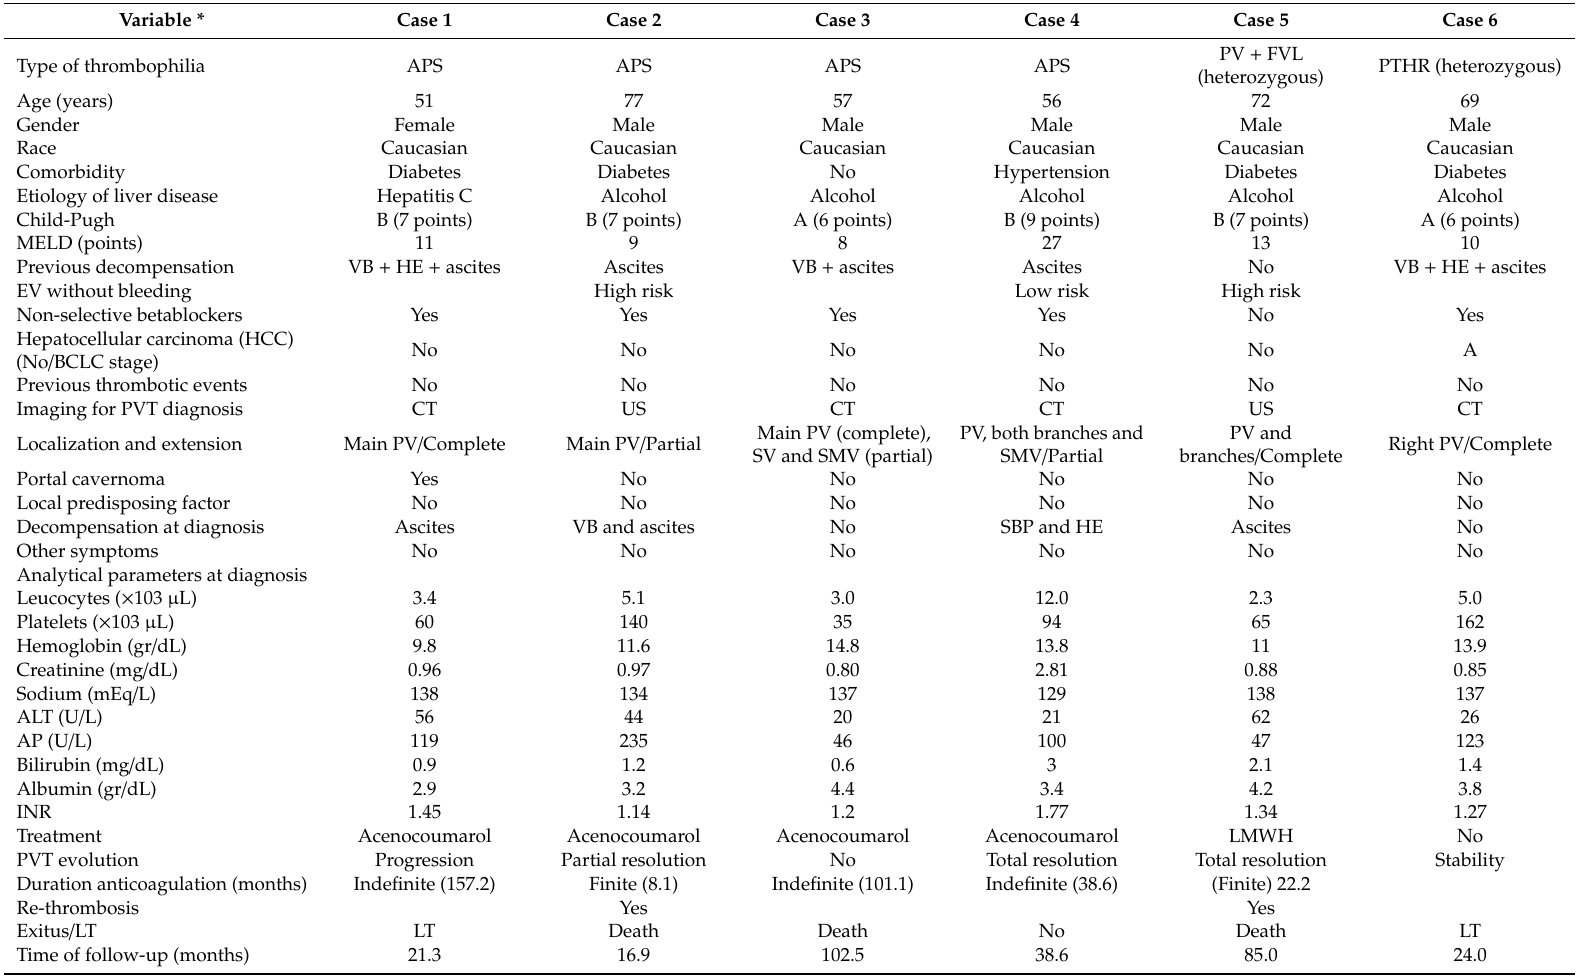
Table 1. Clinical, imaging, endoscopic and laboratory features of patients with